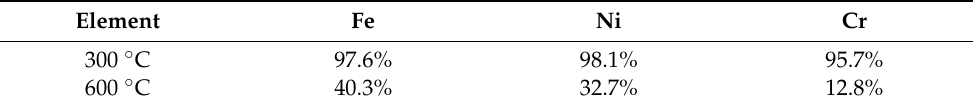
Table 3. The effect of calcination temperature on the leaching percentage.